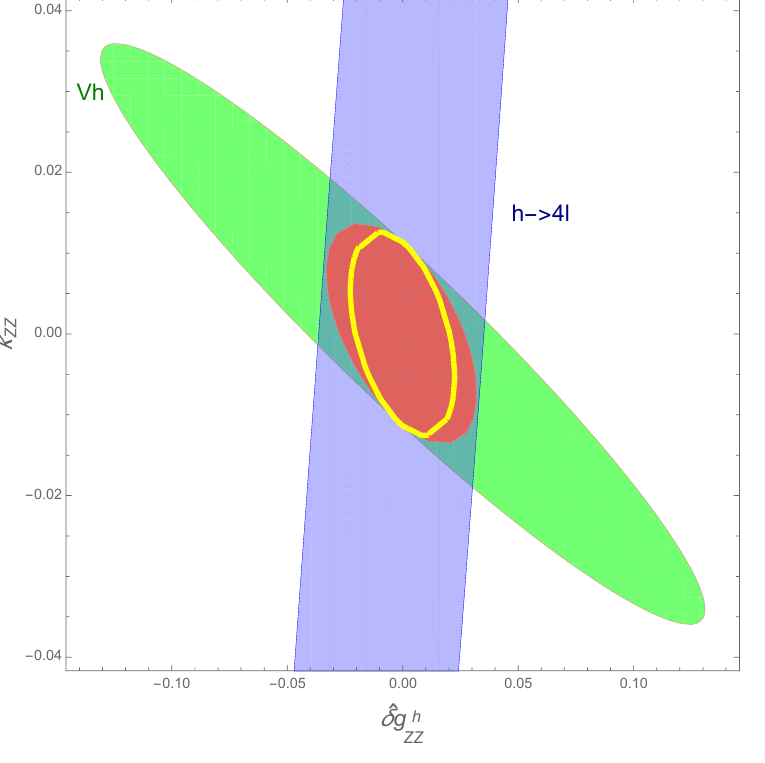
Figure 6 . Bounds at 68 % CL on the CP -even anomalous couplings after combination with the results of the angular moment analysis of the pp → Wh/Zh processes carried out in ref. [51]. The blue band shows the results of this work, the green ellipse the bounds from pp → Wh/Zh processes. The red ellipse is the combination of the present work and moments analysis presented in ref. [51] for the pp → V h processes. Finally, the dashed yellow ellipse shows the final bound after combination with pp → h → WW → 2 ‘ 2 ν process in ref.